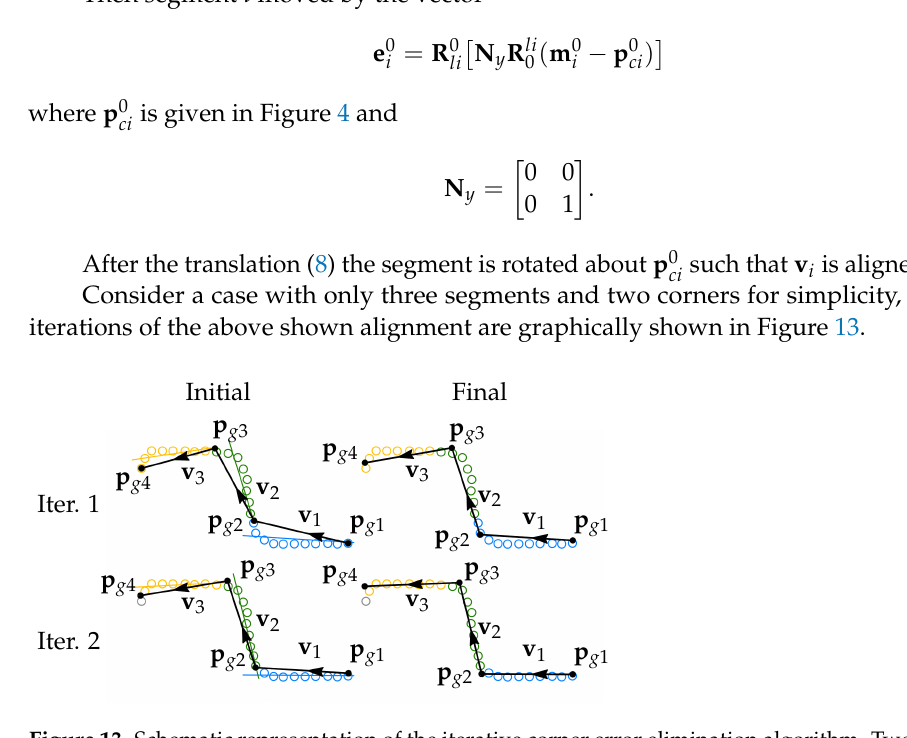
Figure 13. Schematic representation of the iterative corner error elimination algorithm. Two iterations are shown with the initial and final groove profile